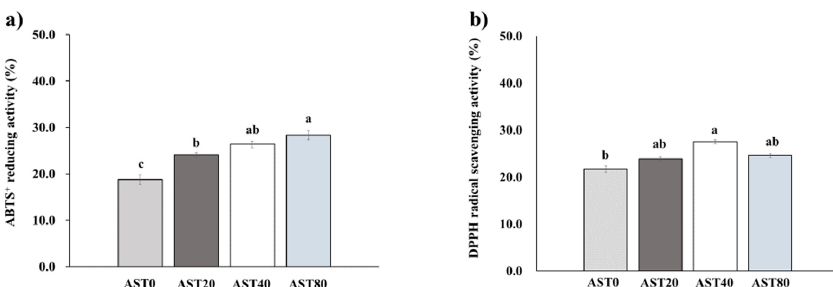
Figure 1. Effect of dietary astaxanthin supplementation levels on 3-ethylbenzothiazoline-6-sulfonate (ABTS +) reducing activity ( a ) and 2,2-diphenyl-1-picrylhydrazyl (DPPH) radical scavenging activity ( b ) of leg muscles in broilers under high temperature. AST0, basal diet; AST20, basal diet + 20 ppm astaxanthin; AST40, basal diet + 40 ppm astaxanthin; AST80, basal diet + 80ppm astaxanthin. ABTS + : linear, p < 0.001; quadratic, p = 0.066. DPPH: linear, p = 0.048; quadratic, p = 0.072. Bars with different letters (a–c) differ significantly across all treatments ( p < 0.05).